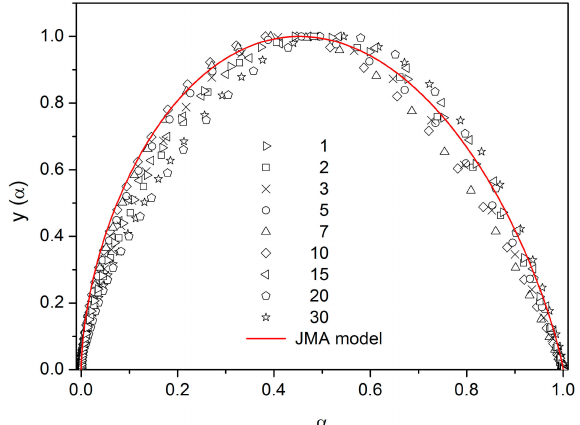
Figure 12. The y( α ) functions obtained by transformation of DSC data shown in Figure 5. Points were calculated by using Equation (15) (numbers indicate heating rate); E c utilized in the calculations were determined from the corresponding dependence shown in Figure 10 for the temperatures matching α = 0.1 of each respective DSC data curve. The solid red line was calculated by Equation (10) for m =